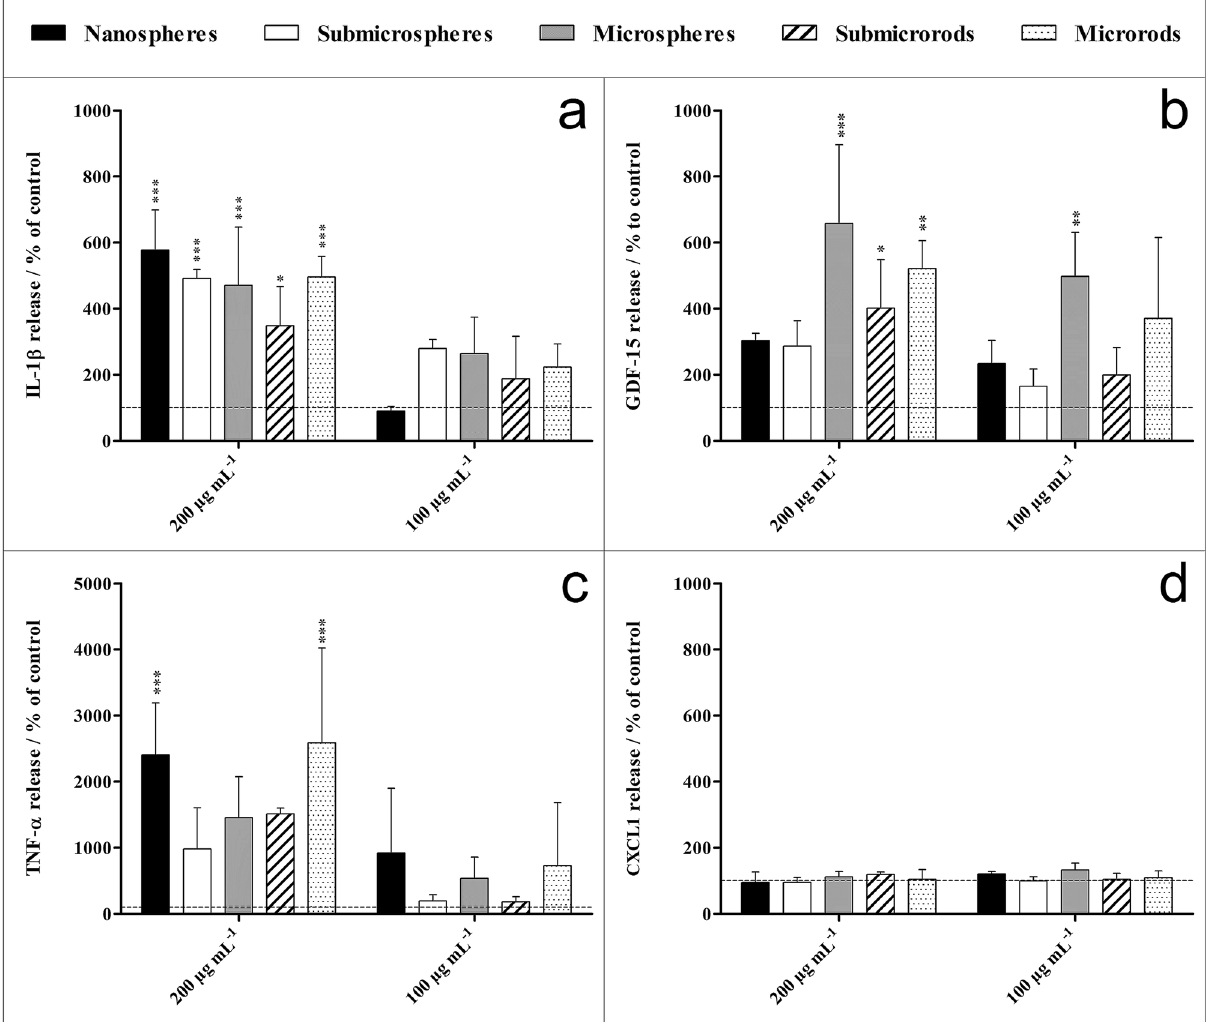
Figure 11. Cytokine release of NR8383 alveolar macrophages after 16 h exposure to different unfunctionalized silica particles as determined by ELISA. The released amount of IL-1β ( a ), GDF-15 ( b ), TNF-α ( c ), and CXCL1 ( d ) of untreated cells (not exposed to silica particles) was 30, 160, 2 and 14 pg mL −1 , respectively. Data are expressed as mean ± SD ( n = 3), given as the percentage of the control (100%, untreated cells). Asterisks (*) indicate significant differences in comparison to the control (* p < 0.05, ** p < 0.01, *** p < water (30 mL) and stirred at 30 °C for 30 min. After cooling the solution to room temperature, ammonia (0.3 mL, 25%) was added to the CTAB solution and stirred for 20 min. Then, TEOS (0.25 mL) was added and the reaction mixture was stirred for 1 h. After 7 min, the originally clear solution had assumed a turbid white color. For the synthesis of silica microrods, CTAB (0.3 g) was completely dissolved in water (40 mL) and stirred at 30 °C for 30 min. Ammonia (1 mL, 30%) was added. After 20 min, TEOS (1.8 mL) was added and stirring of the reac- tion mixture was continued at room temperature for 1 h. Silica submicrorods and microrods were collected by centrifugation (3500 rpm, 30 min) and washed with ethanol several times. In the next step, the particles were was redispersed in ethanol and heated at 60 °C for 6 h in an ethanolic HCl solution (EtOH:HCl = 0.99:0.01 v / v ) to remove the organic surfactant (CTAB). The silica particles were purified by triple centrifugation (3500 rpm, 30 min) in ethanol and dried at 200 °C for 3 h. The quantitative absence of CTAB was shown by IR spectroscopy (Fig. 3). The number of particles in 1 g solid was then computed from the average particle mass for spheres and rods: 4 m = π r 3 ρ sphere 3